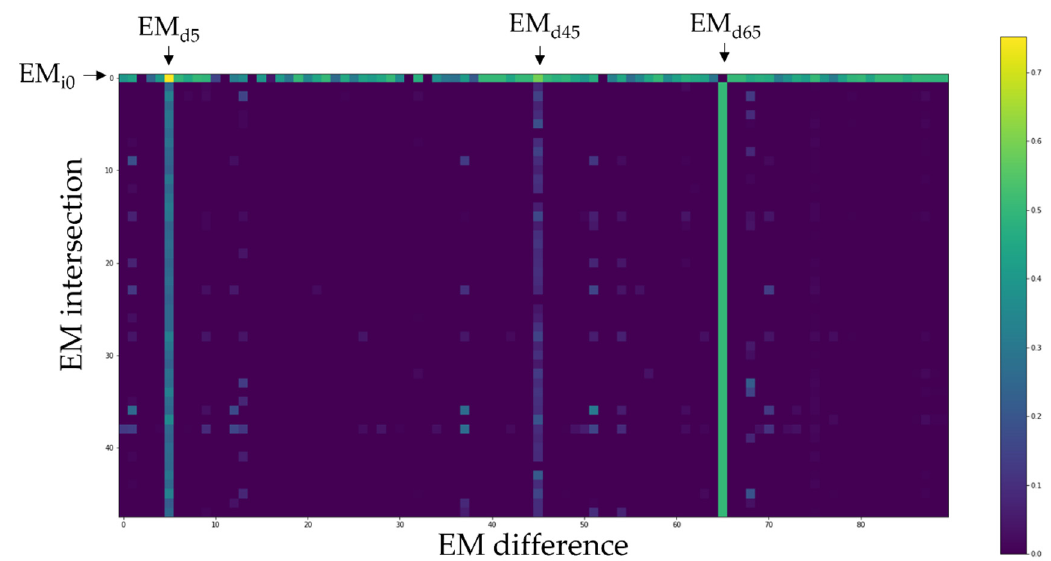
Figure 5. Spectral unmixing example based on synthetic mixing result.